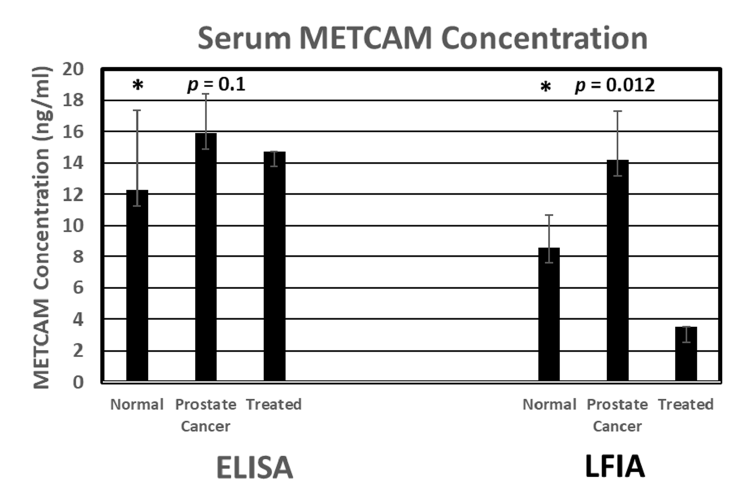
Figure 3. The serum METCAM concentrations determined by gold nano ‐ particle ‐ based LFIA in comparison with ELISA [42]. Consequently, it was revealed that METCAM was highly likely to serve a new biomarker for the diagnosis of the malignant potential of prostatic carcinomas.“*” is the reference data for statistical analysis.